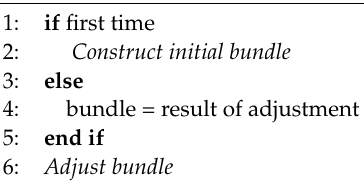
Algorithm 3 Mission planning: